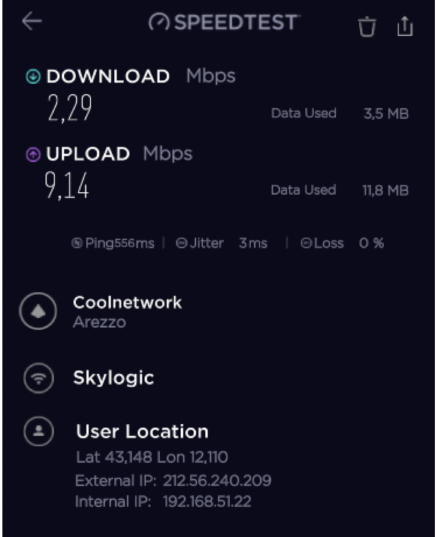
Figure 17. B-LiFE deployment in Turin, Italy, during the COVID-19 crisis: speed test results for the SES Scorpion MP80X